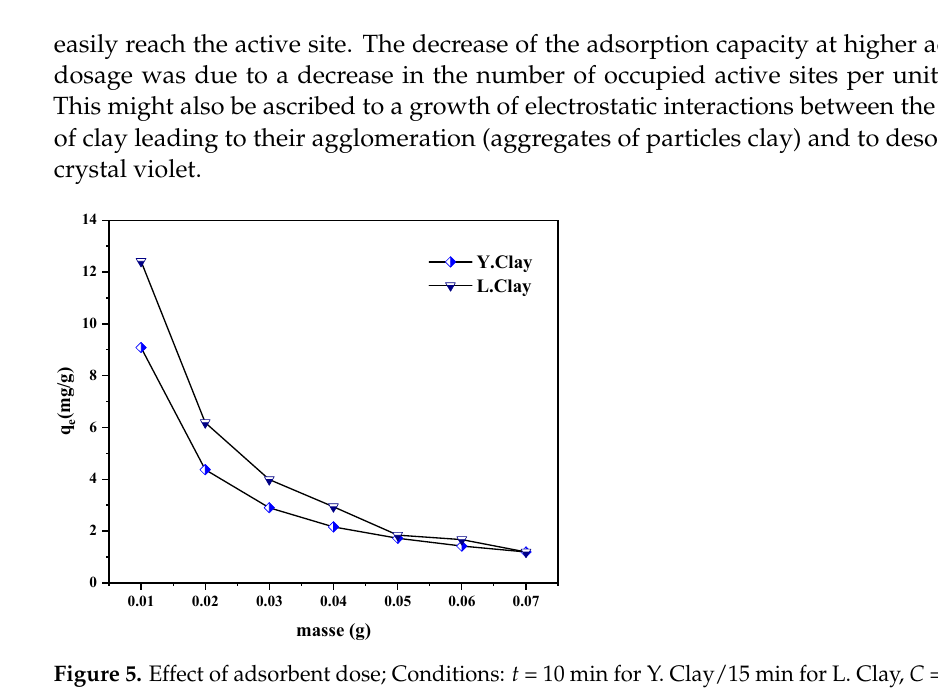
Figure 5. Effect of adsorbent dose; Conditions: t = 10 min for Y.Clay/15 min for L.Clay, C = 12 mg/L, T = 30 ◦ C.